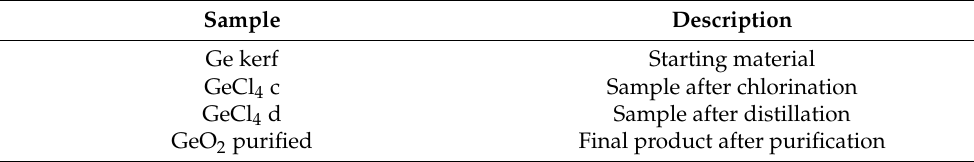
Table 5. Samples analyzed.